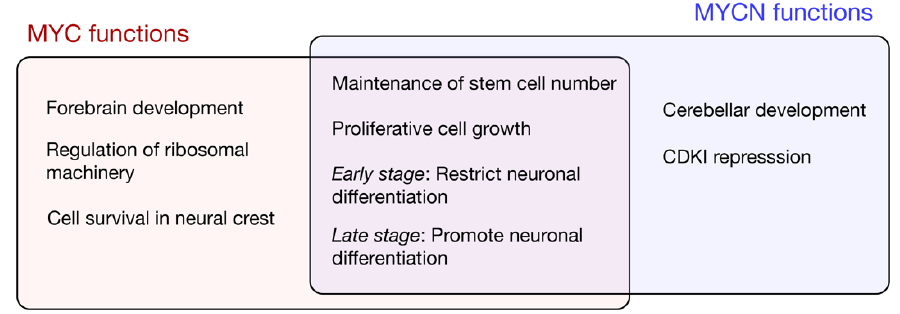
Figure 2. MYC and MYCN functions in the neural lineage.